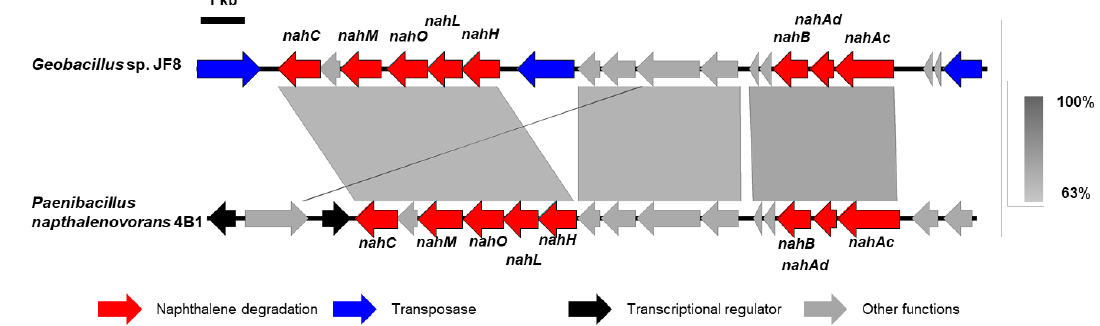
Figure 5. Alignment of nah gene clusters of strain JF8 with that of Paenibacillus naphthalenovorans 4B1. Coding sequences of each genome are shown as colored